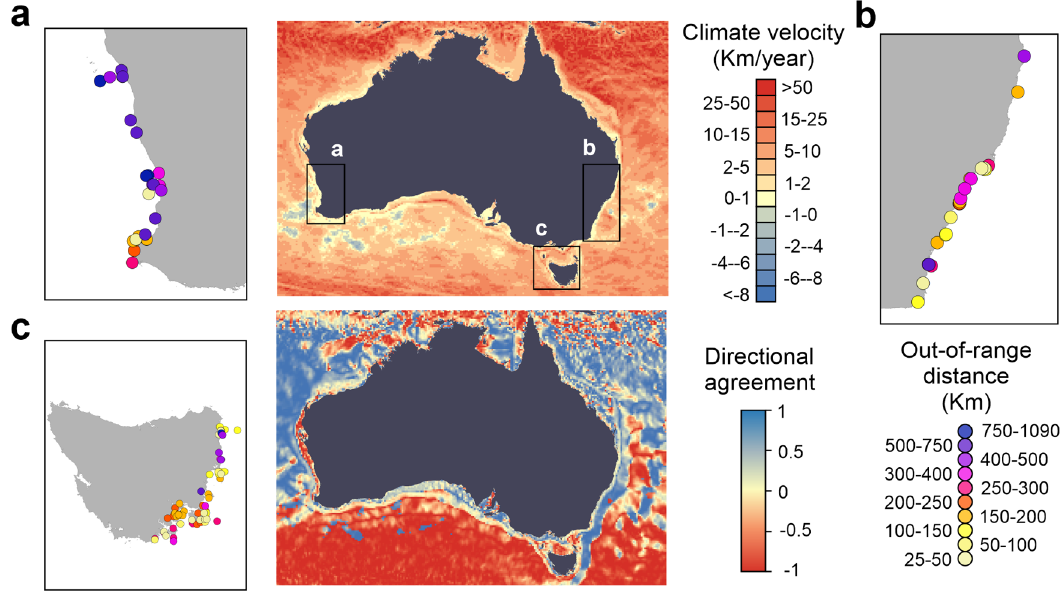
Fig. 3 The velocity of climate change, its directional agreement with ocean surface currents, and the locations of out-of-range observations. The velocity of climate change and its directional agreement with average mean annual surface currents (1994 – 2018). Inset panels show the out-of-range observations from ( a ) western Australia, ( b ) eastern Australia and ( c ) Tasmania ( n = 127) colored by their corresponding maximum annual coastal extension distances relative to the historical southern distribution limit of each species. Note that multiple observations for the same species over consecutive years are possible along the same coastline (see Methods for details).